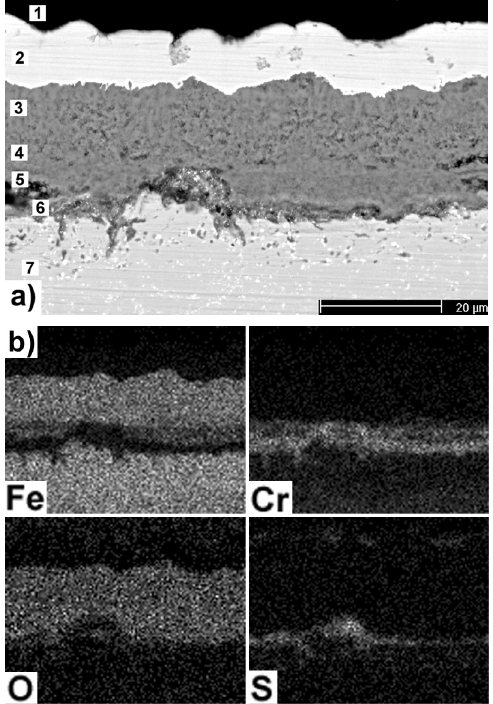
Figure 15. Cross-section of uncoated HCM12A after 336 hours at 883 K in N 2 (cid:3) 1000 ppmv HCl (cid:3) 100 ppmv SO 10 % H 2 O (cid:3) 8:4 % O 2 . a) BSE-image. 1) Mounting. 2) Nickel coating. 3) Fe 2 O 3 . 4) Original surface. 5) Cr- rich layer. 6) Cr-rich layer with S. 7) Substrate. b) Corre- sponding elemental maps for Fe, Cr, O and S.